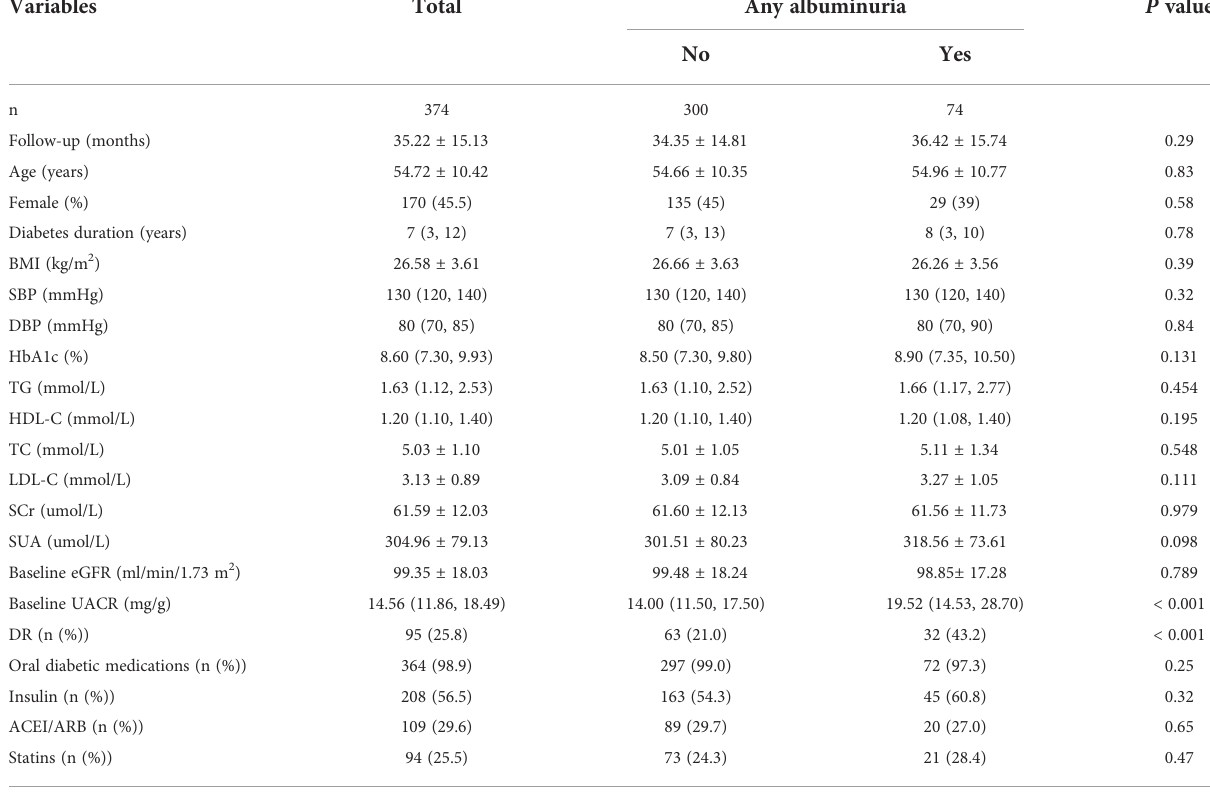
TABLE 5 Baseline characteristics of patients with T2DM according to the presence or absence of albuminuria in development cohort.